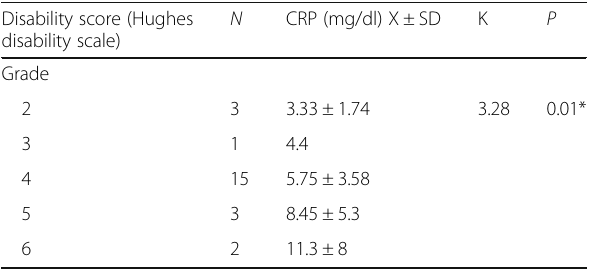
Table 5 Relation between Hughes disability scale score and mean serum CRP level among the studied GBS patients Disability score (Hughes disability scale)